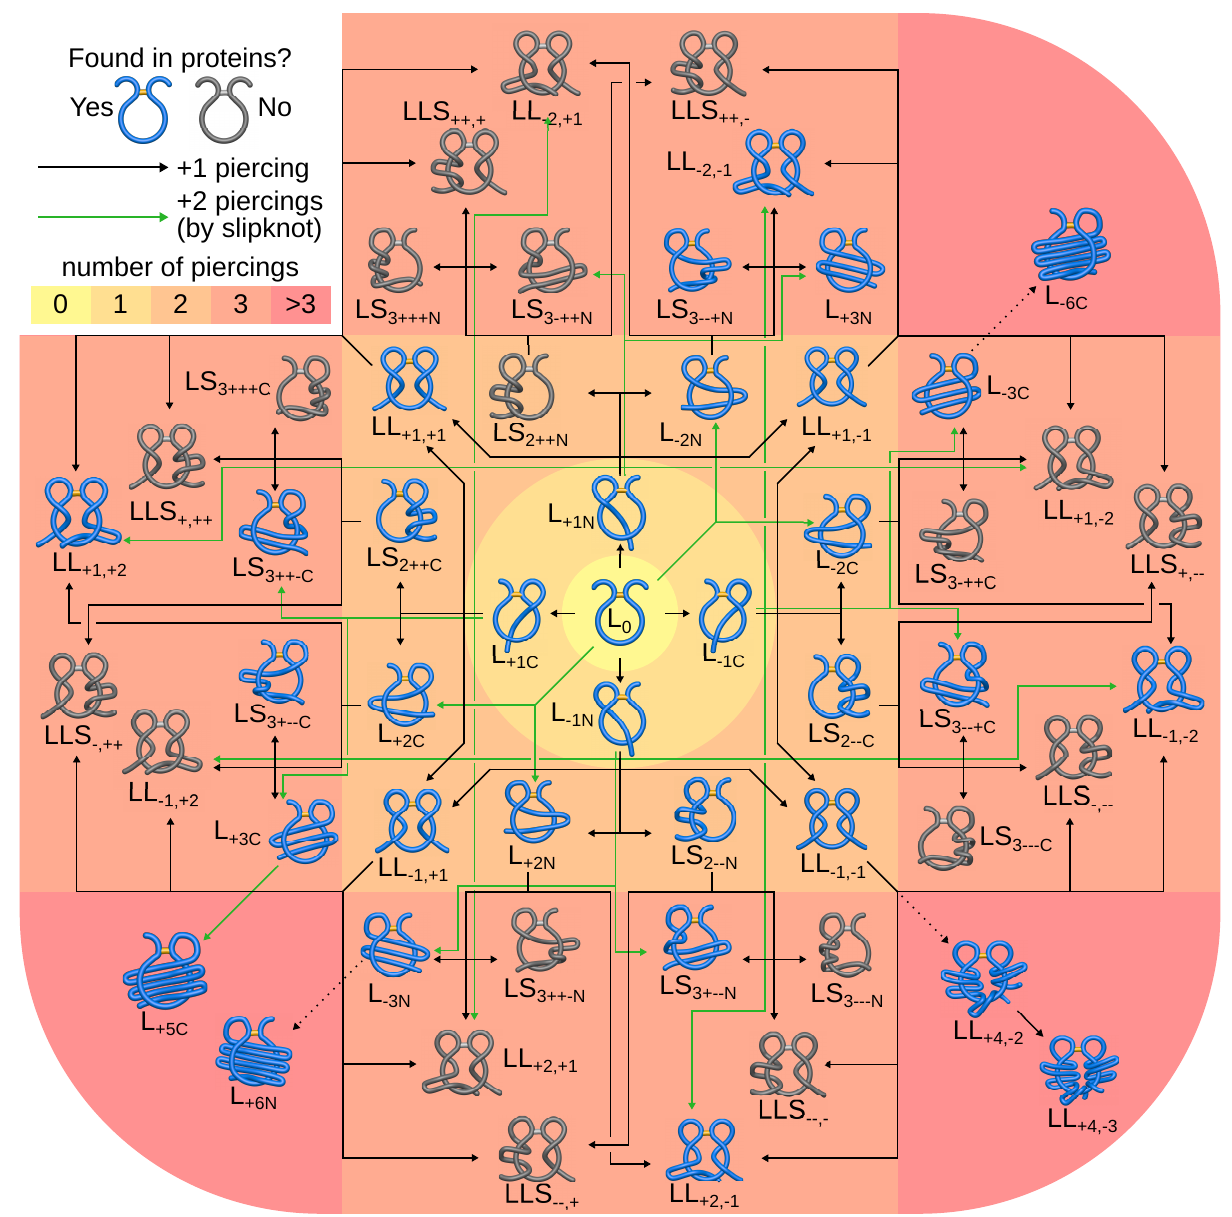
Figure 2. The “evolution flower” of lasso types. The figure shows all possible lasso motifs with up to three piercings and observed lassos with higher number of piercings. The structures observed in PDB are shown in blue, and those not observed (up to 3 piercings) are shown in grey. The structures are grouped according to the total number of piercings (shown by the colored background). The lasso types that can be formed by the addition or reduction of a terminal piercing are joined by a solid black line. Lasso types that can be formed by the addition or reduction of a terminal slipknot piercings are joined by a solid green line. Please note that some lasso motifs can be obtained in more than one way. The dotted lines denote the possible evolution pathway, for which however, some intermediate lasso types have not yet been